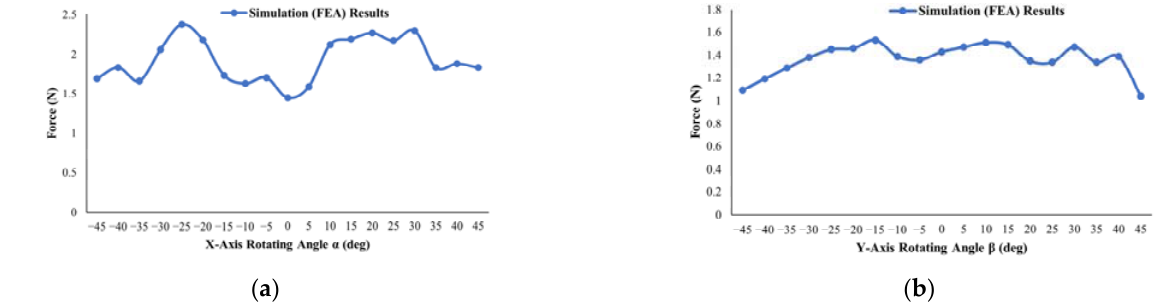
Figure 11. Force values of the motor at the loaded condition rotating around the X ‐ axis from α = 0° to α = ±45° ( a ) and rotating around the Y ‐ axis from β = 0° to β = ±45° ( b ).